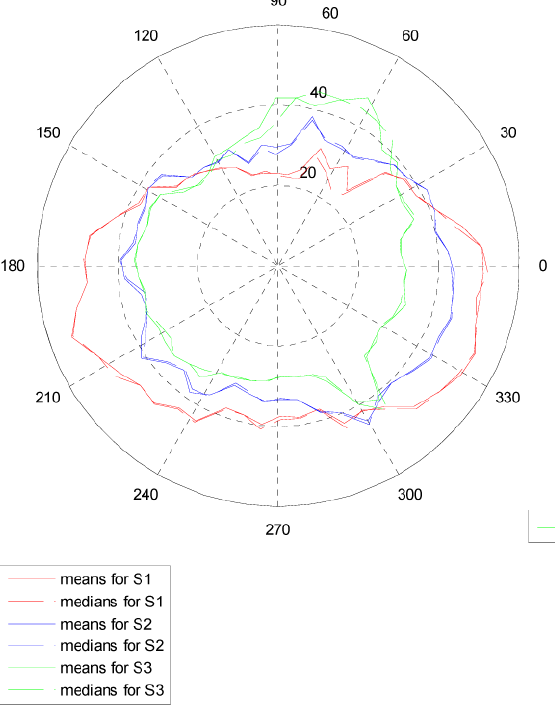
Figure 5. Polar plots of the meridional means (solid profiles) and medians (dashed profiles) for ocular ACA for the right eyes of three young female subjects. Different colours are used to represent the different subjects (see the legend). The radial co- ordinates range from 0 to 60 0 , that is, the further away a coloured profile is from the polar origin the larger the ACA for the merid- ian/s concerned. Numbers around the circumference represent reference meridian in degrees. The superior nasal quadrants for these right eyes are represented by meridians 0-90 0 .